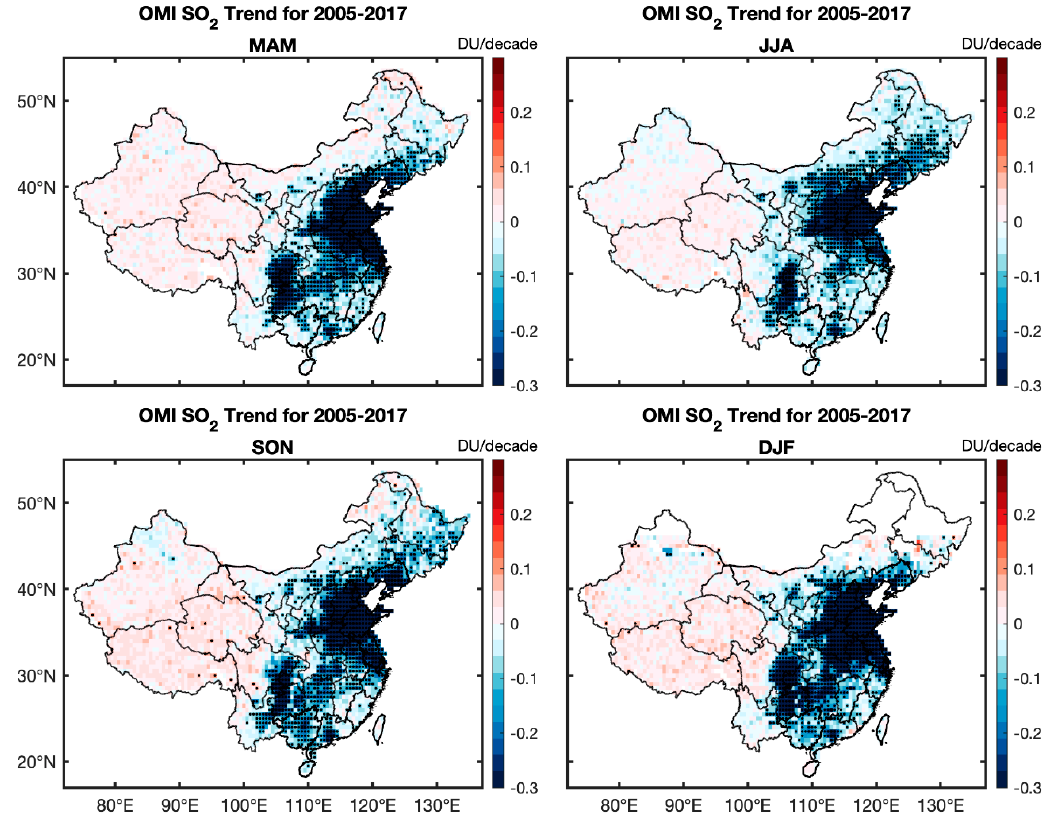
Figure 9. Seasonal OMI SO 2 trends for 2005–2017.